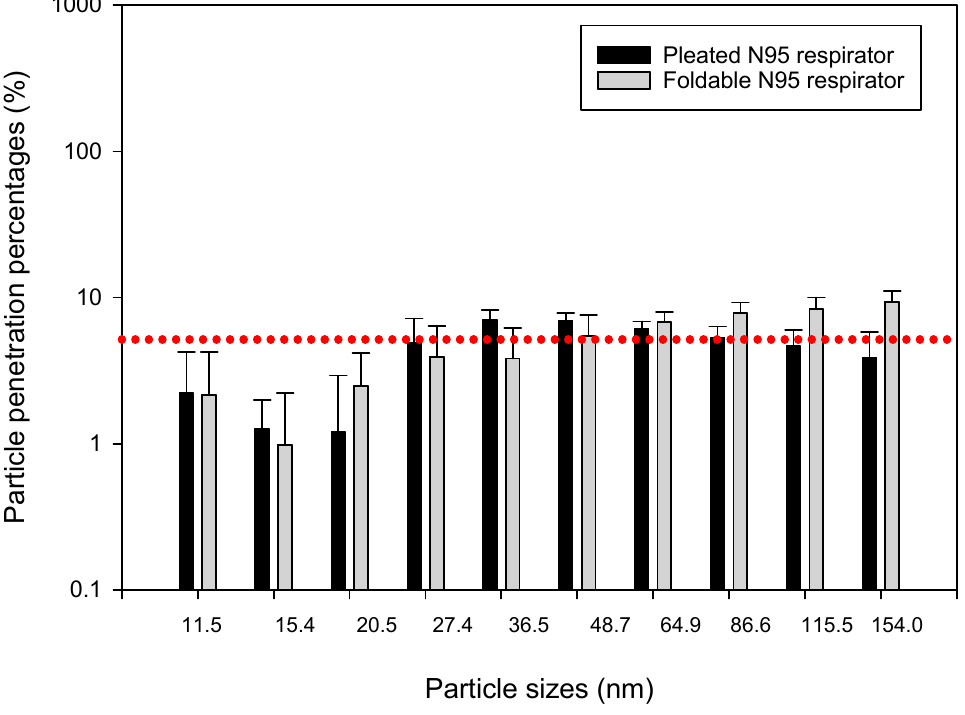
Figure 6. Penetration percentages of particles of 11.4–154.0 nm size range during soil moving by bulldozers in a large construction site. The dotted red line indicates the 5% particle penetration percentages, to be considered as the efficacy threshold for N95 respirators.